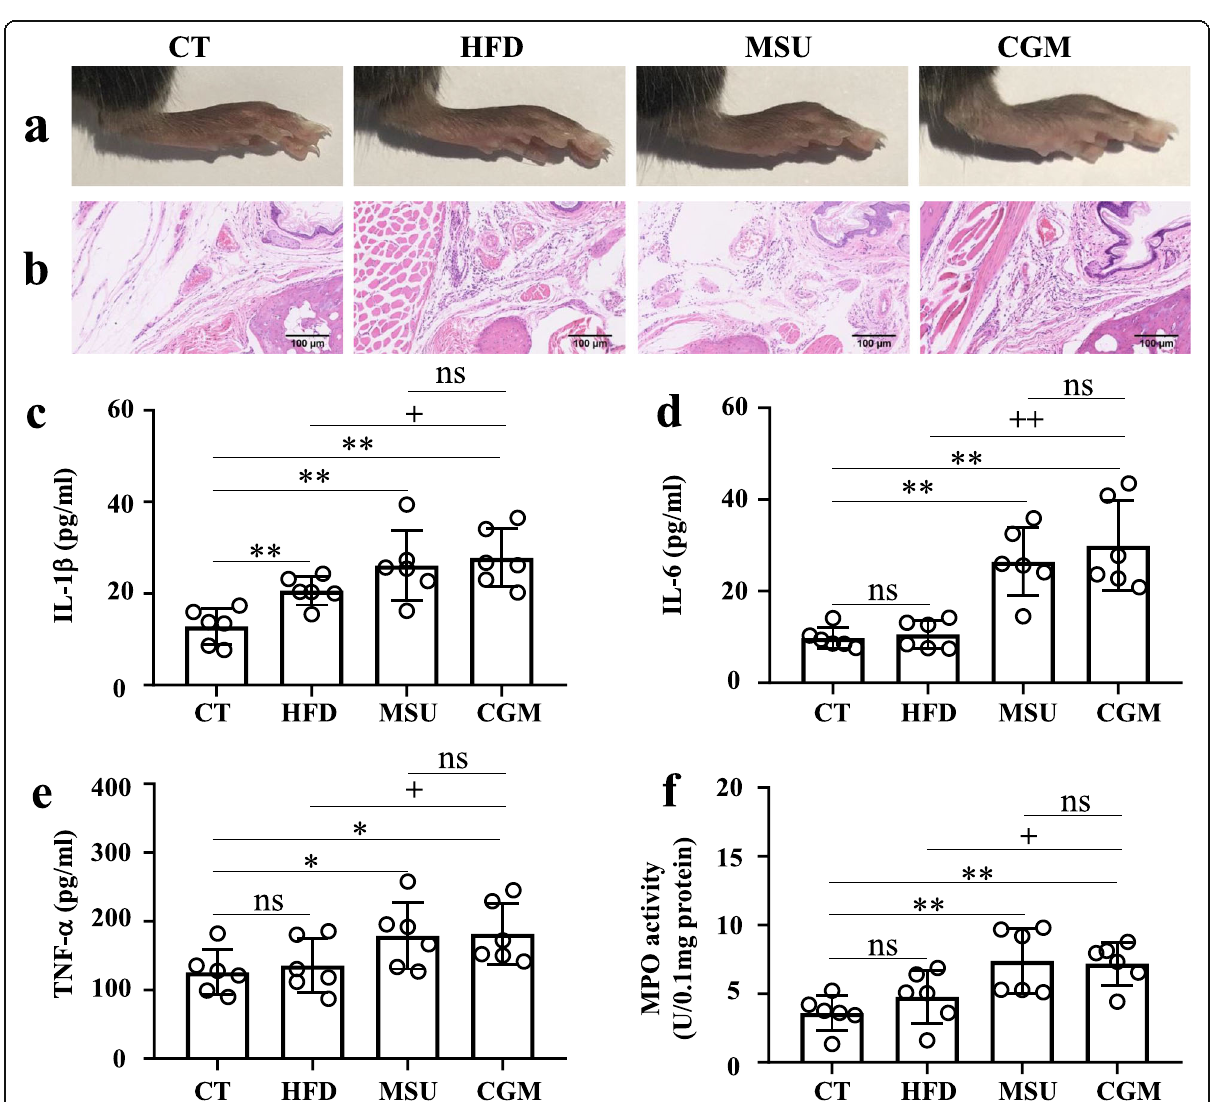
Fig. 2 Gout inflammation indexes of mice in the four groups. Representative images of foot joint ( a ) and H&E stained histological ( b ); IL-1 β ( c ); IL-6 ( d ); TNF- α ( e ); MPO activity ( f ). CT: control group; HFD: hyperuricaemia model; MSU: acute gout model; CGM: compound gout model. “ ns ” represents not significant; “ * ” represents p <0.05 in comparison with CT; and “ ** ” represents p <0.01 in comparison with CT; “ + ” represents p <0.05 in comparison with CGM; and “ ++ ” represents p <0.01 in comparison with